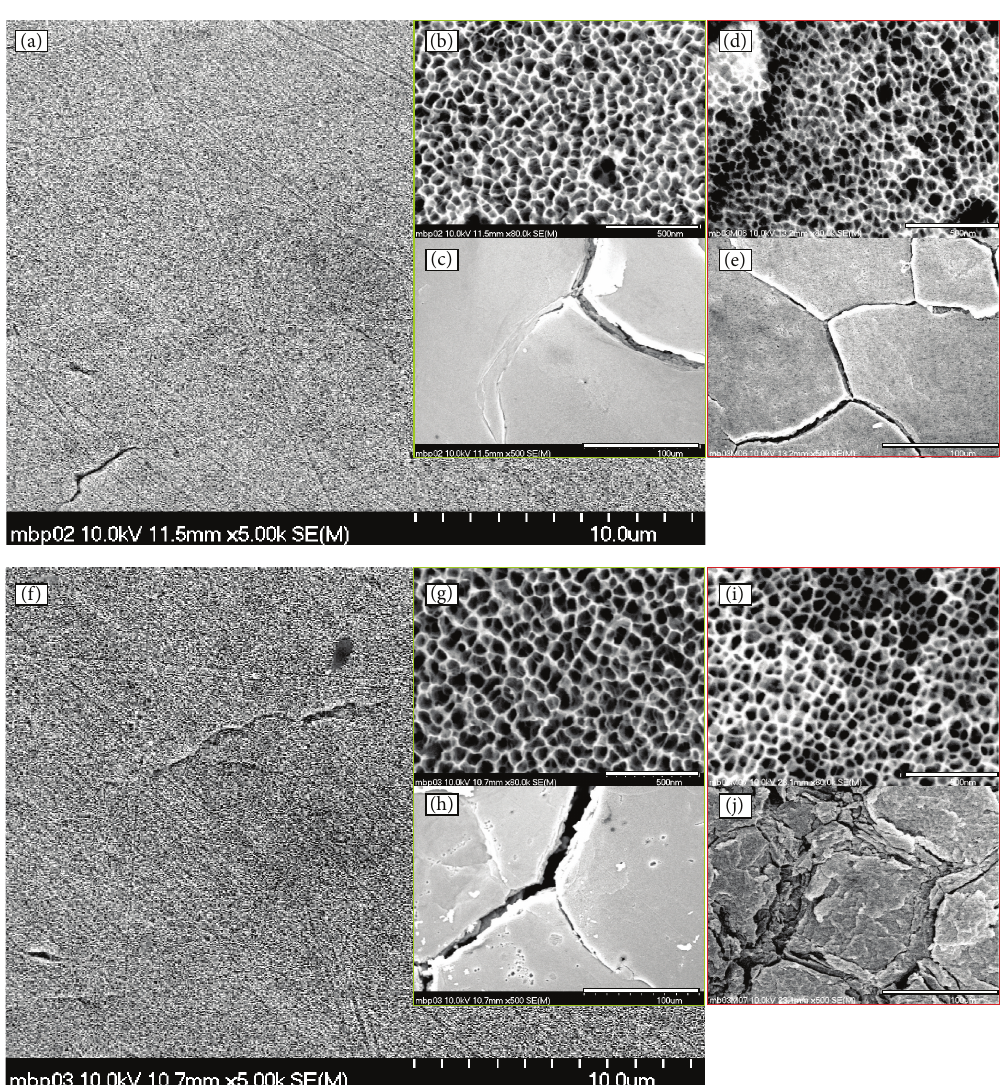
Figure 7: FE-SEM images of nanoporous tin oxides formed during 1800 s anodization of the high-purity (a–c, f–h) and low-purity (d-e, i-j) Sn foils in a 0.3 M oxalic acid electrolyte at the potential of 6 V (a–e) and 7 V (f–j). Scale bars in inset images indicate 500 nm (b, d, g, and i) and 100 𝜇 m (c, e, h, and